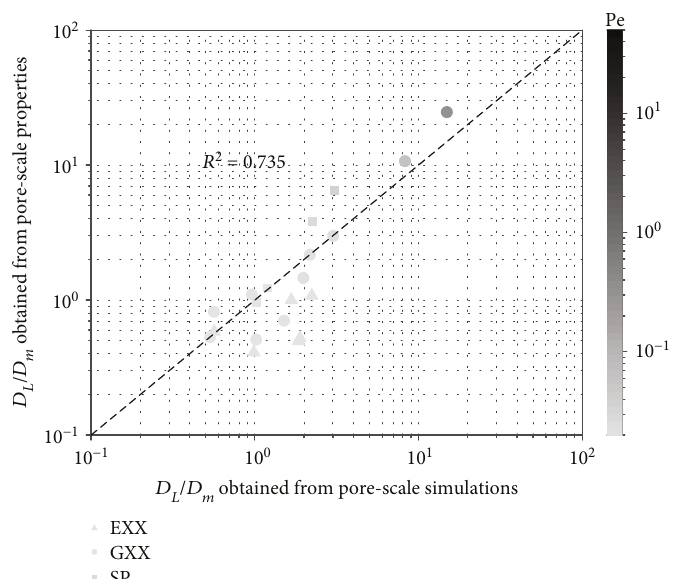
Figure 8: Comparison between the hydrodynamic dispersion coe ffi cients calculated from the advection-di ff usion simulation using equation (11) and the dispersion coe ffi cients obtained from Mostaghimi et al. [16] and Icardi et al. [36] and de fi ned in equation